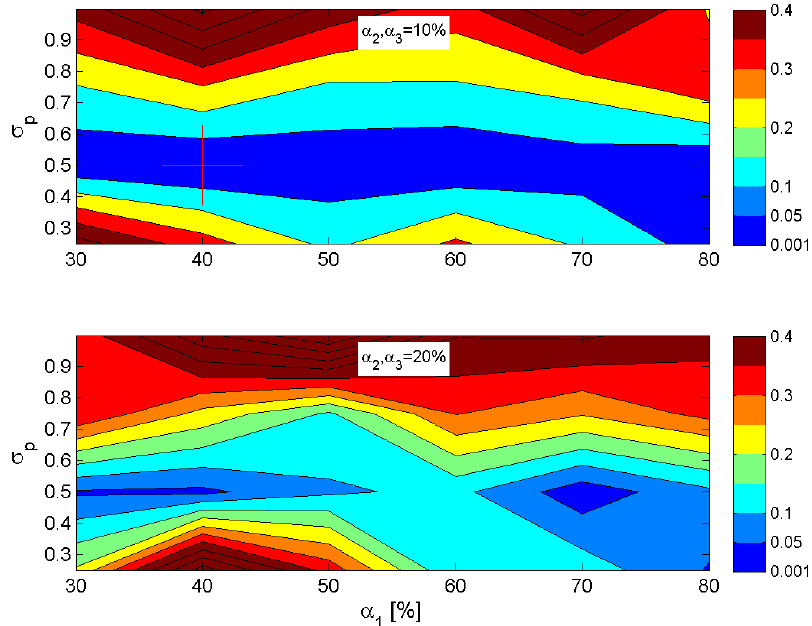
Figure 3. Contour plot of the function F of Equation (10) as a function of the standard deviation of the precipitation σ p , the percentage α 1 of the perturbation of the maximum water storage W max , and the percentages α 2 , α 3 of the parameters of drainage, Ks and evapotranspiration Kc , respectively (period 2000–2009, catchment NE-MA). The optimal value of these standard deviations is identified by the red cross and corresponds to the minimum value of the function F representing the error made in the identification of the optimal value of the tests. It can be clearly seen a problem of equifinality in the figure with darker blue areas (smaller F) covering a large part of the